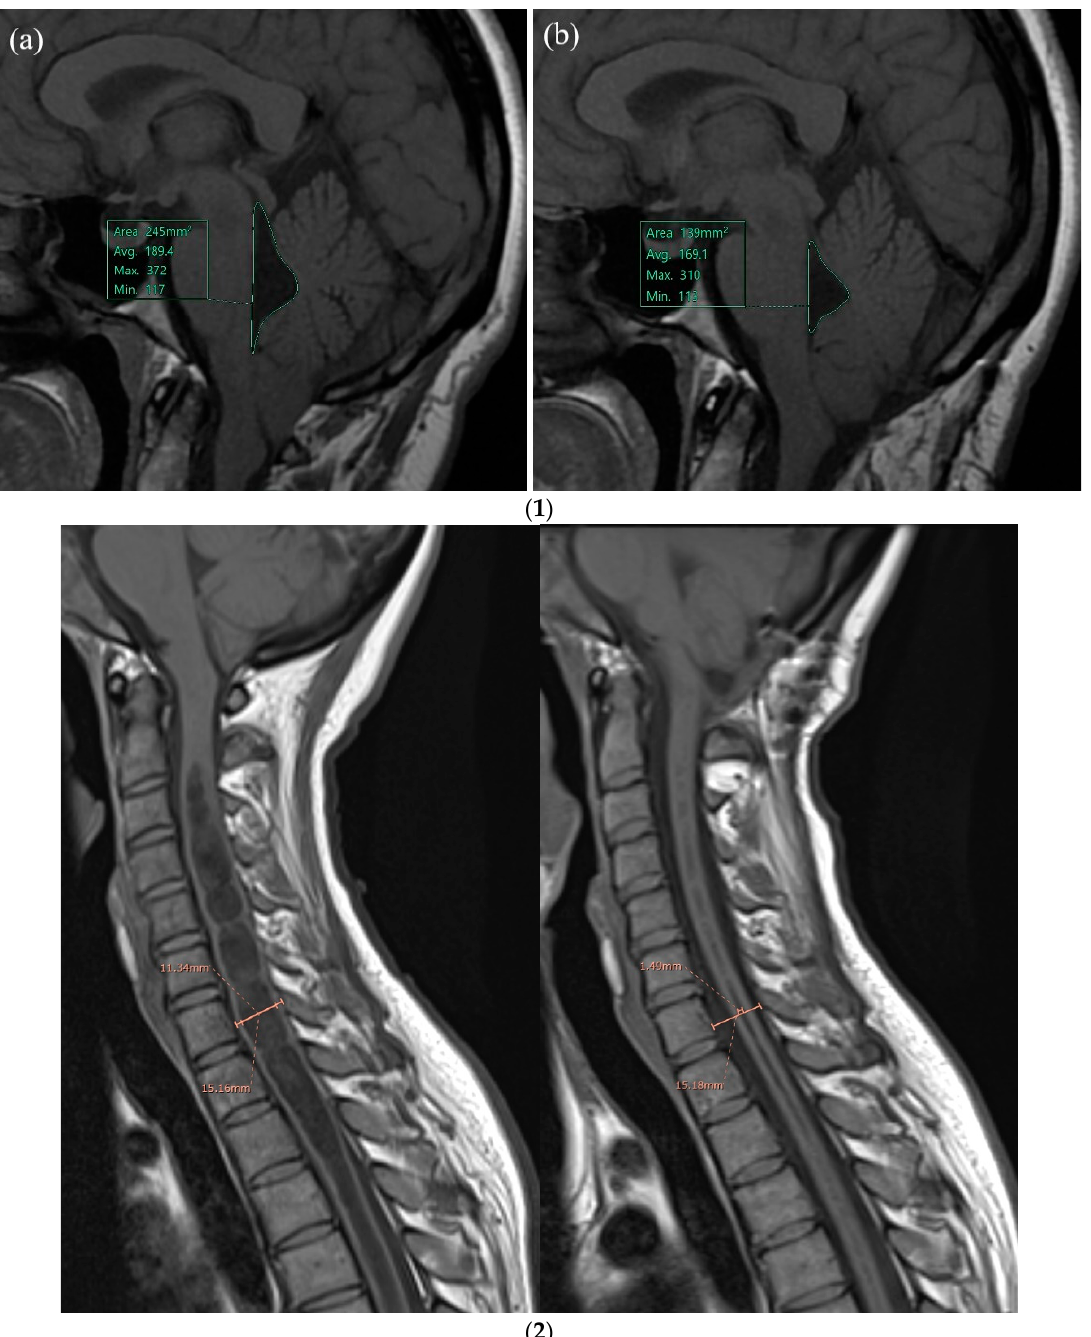
Figure 2. ( 1 ) Illustrative case: Fourth ventricle area measurements, pre (a) and post (b) surgery: 32-year-old female, Syr with CM1, pre ( a ) and post-surgery ( b ). Fourth ventricle area at T1-weighted MR imaging, acquired in the sagittal orientation. ( a ) Fourth ventricle area at T0 (presurgery) was 245 mm 2 and ( b ) fourth ventricle area at T1 (post-surgery) was significant reduced (139 mm 2 ). ( 2 ) Illustrative cases: Vaquero Index measures pre- and post-surgery: 32-year-old female, Syr associated with CM1. Pre ( a ) and post-surgery ( b ). The size of syrinx using the Vaquero Index (VI = ratio of the greatest width of the syrinx to that of the spinal canal at the same level, C7) in a midsagittal T1-weighted spine MR was measured. Syrinx size presurgery (VI = 0.75) was wide and strongly reduced after surgery (VI = 0.1).